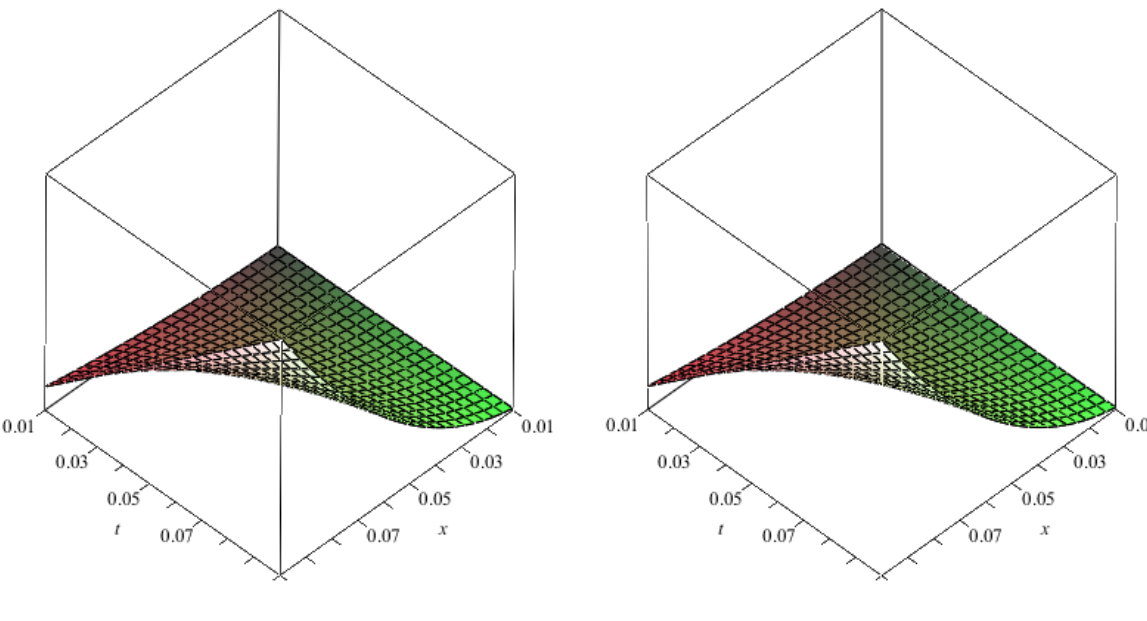
Fig. 9 Exact solution of v 3 ( x , t ) . Fig. 10 Values of v 3 ( x , t ) for α = 1.